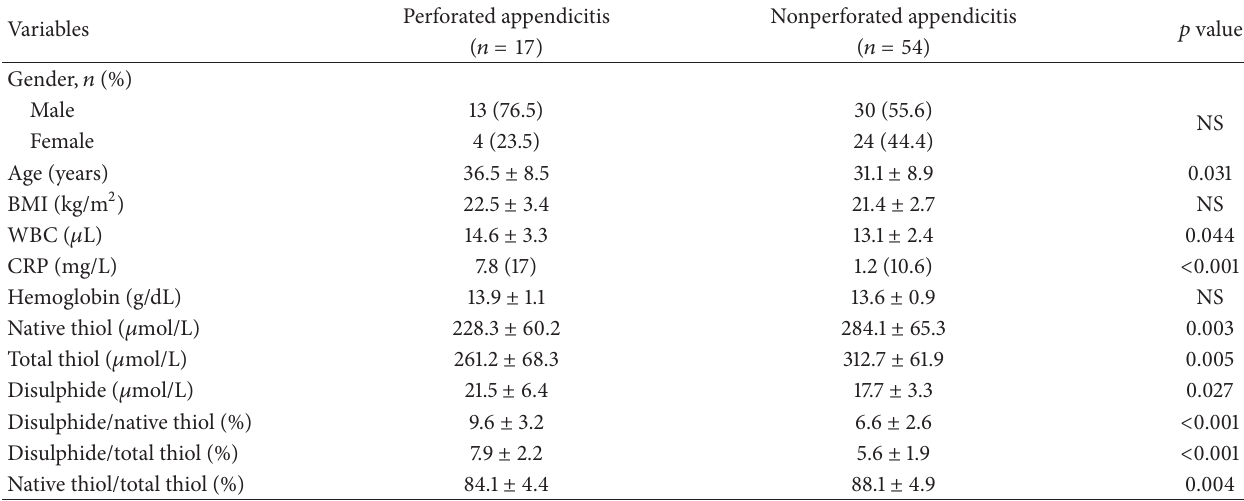
Table 2: The demographics and laboratory findings of patients in AA